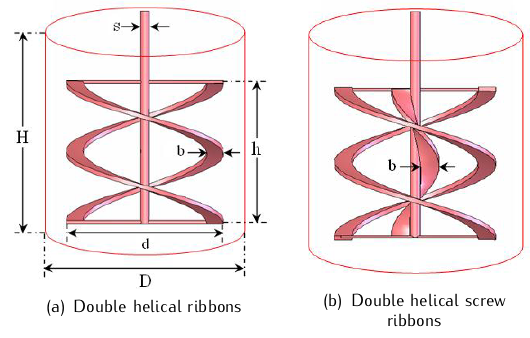
Figure 1. Stirred tank equipped by proximity